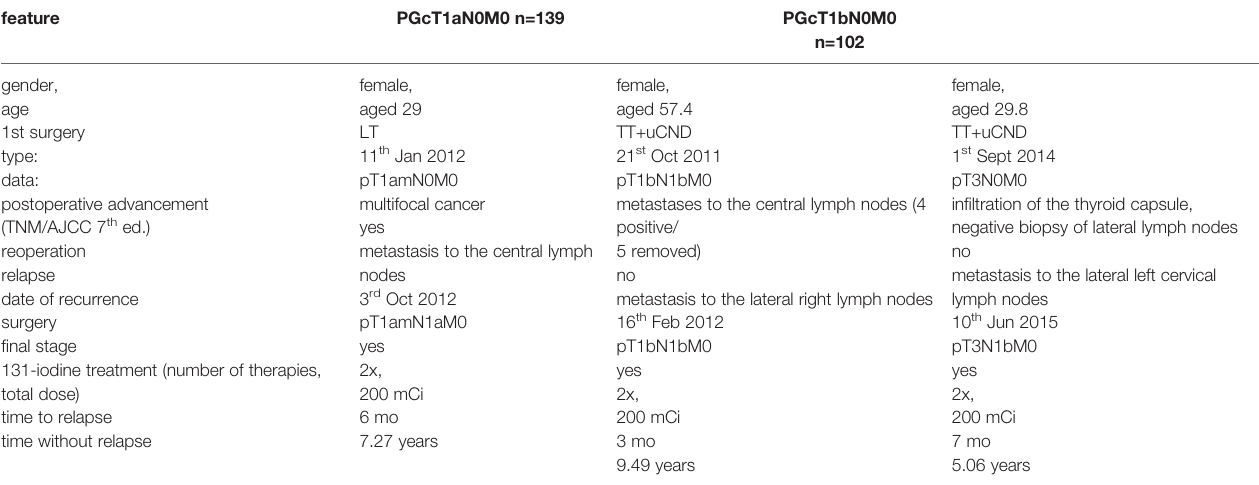
TABLE 4 | Detailed description of relapses in the PG group.